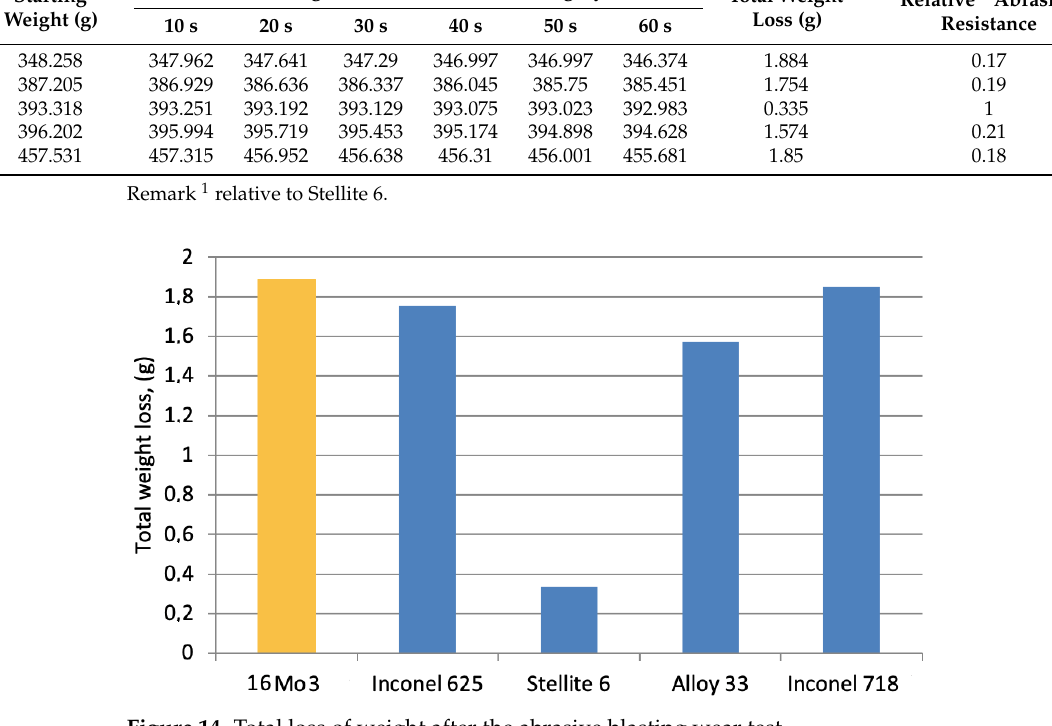
Figure 14. Total loss of weight after the abrasive blasting wear test.